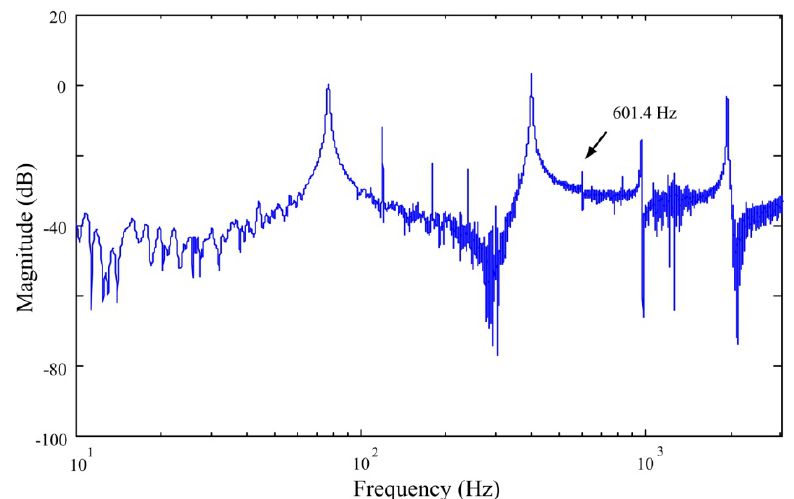
Figure 11. Frequency response of the smart cantilever beam obtained by the strain gauge.